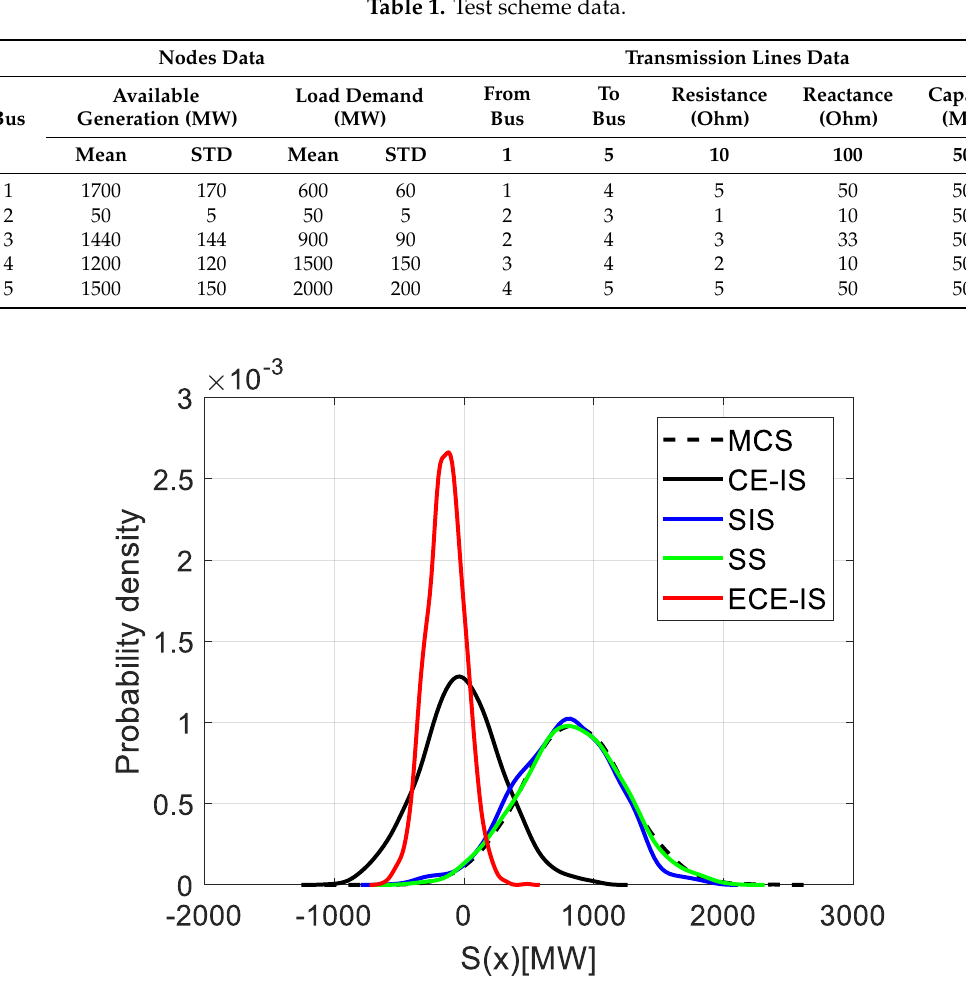
Figure 5. Probability distribution of system limit-state function for different methods.